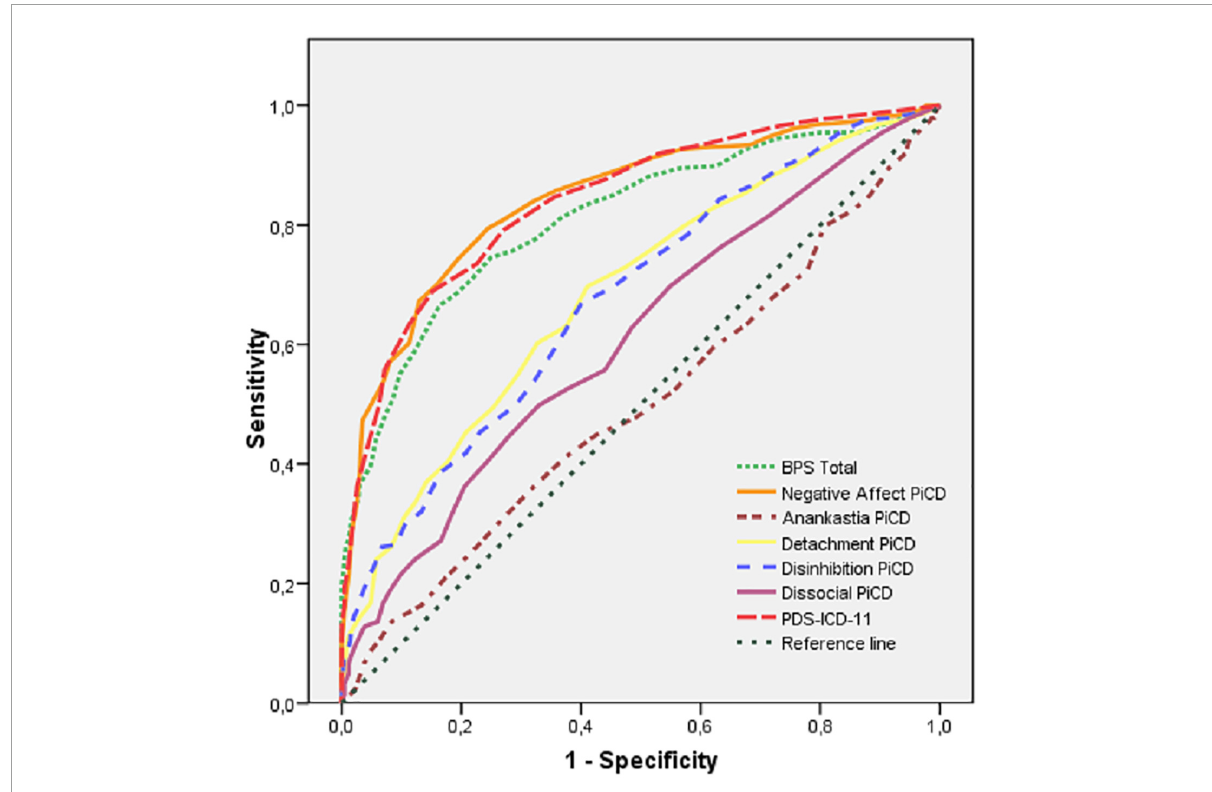
FIGURE2 ROC curves for the components of the ICD-11 PD system predicting